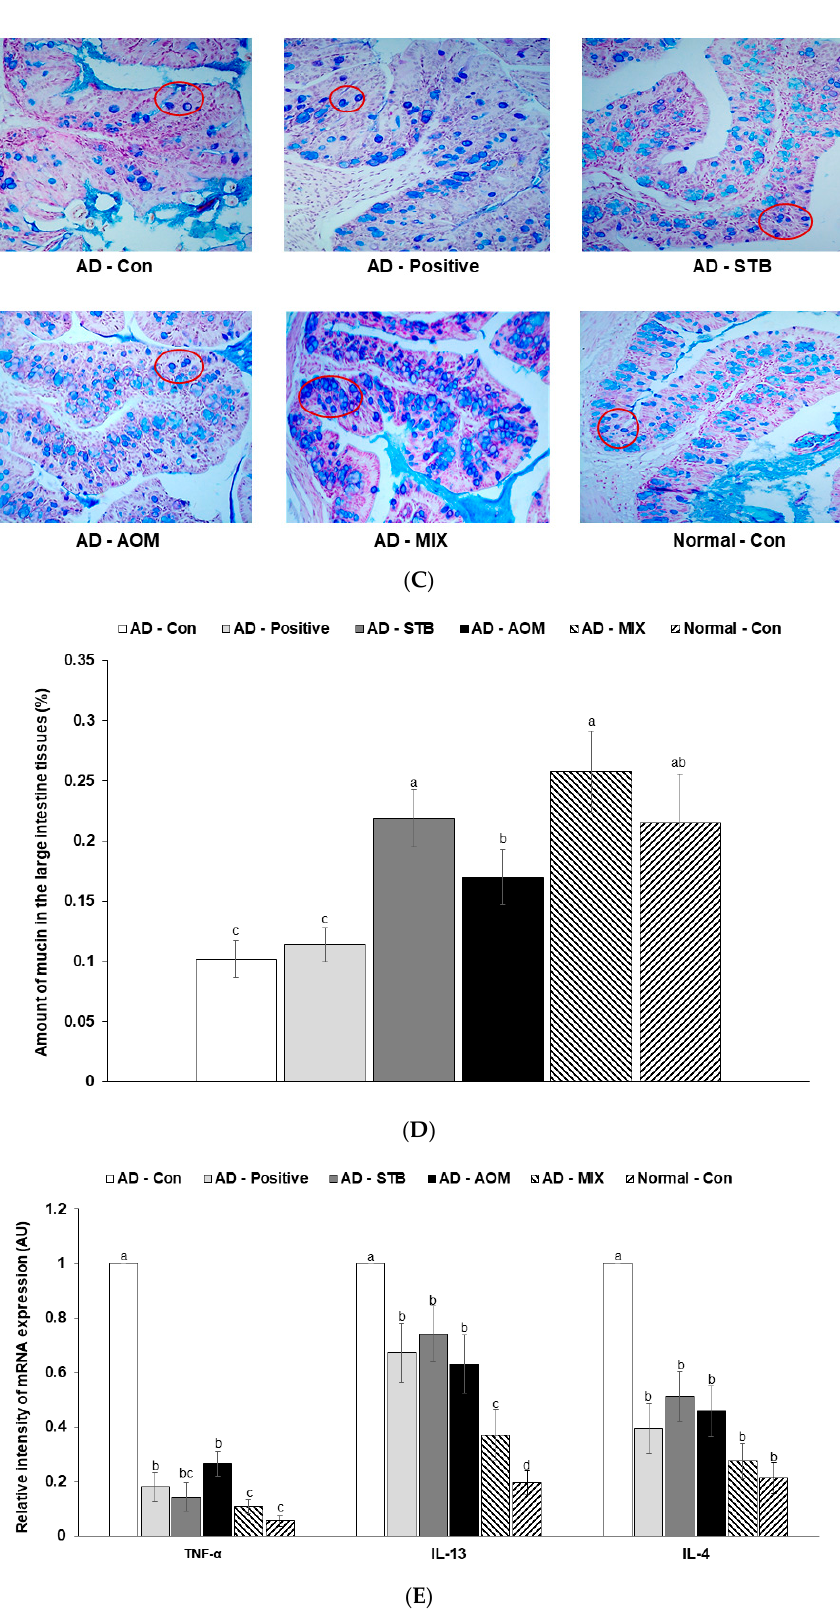
Figure 4. The histological di ff erences and the amounts of mucin in the intestinal tissues among di ff erent groups. The intestinal tissues were fixed with 10% formaldehyde, embedded in para ffi n and then sections were prepared. The skin sections were stained with hematoxylin and eosin and toluidine